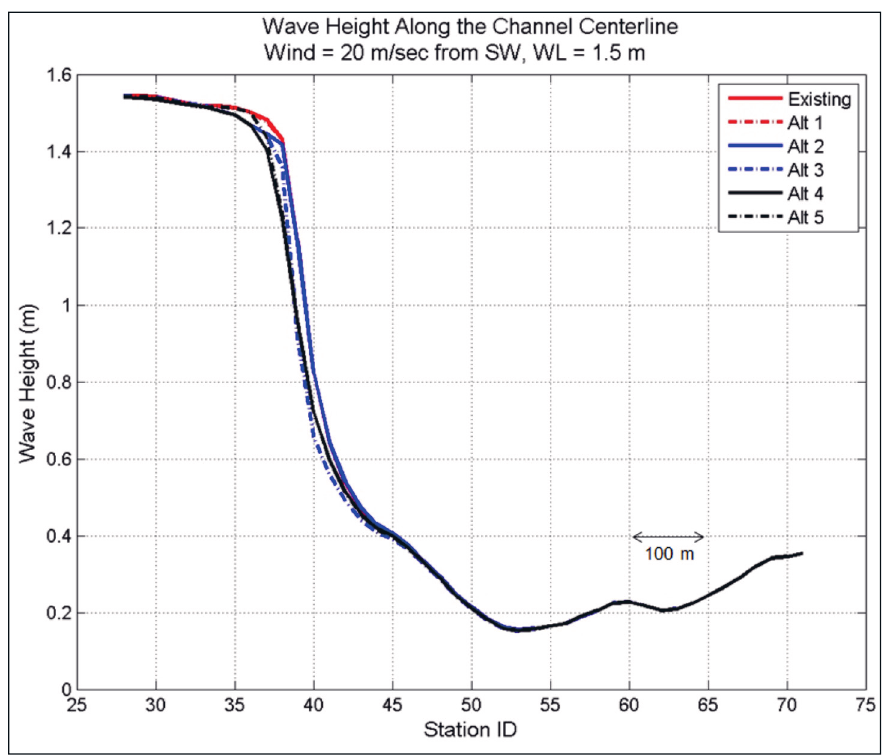
Figure 24. Model wave heights in the west channel for 50-year design wind from SW and WL = 1.5